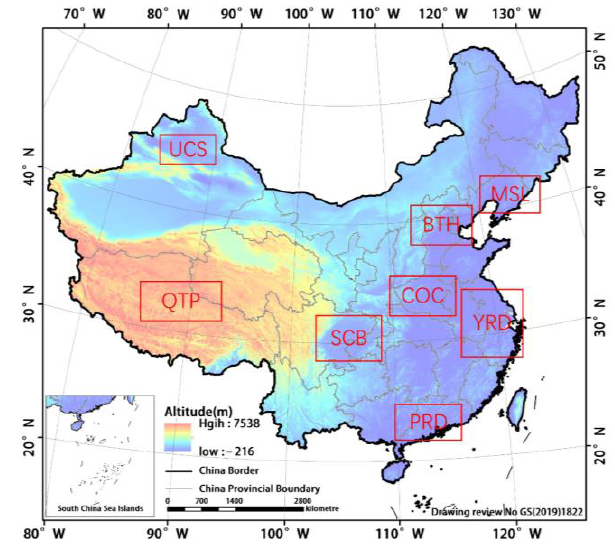
Figure 1. Elevation map of the study area.